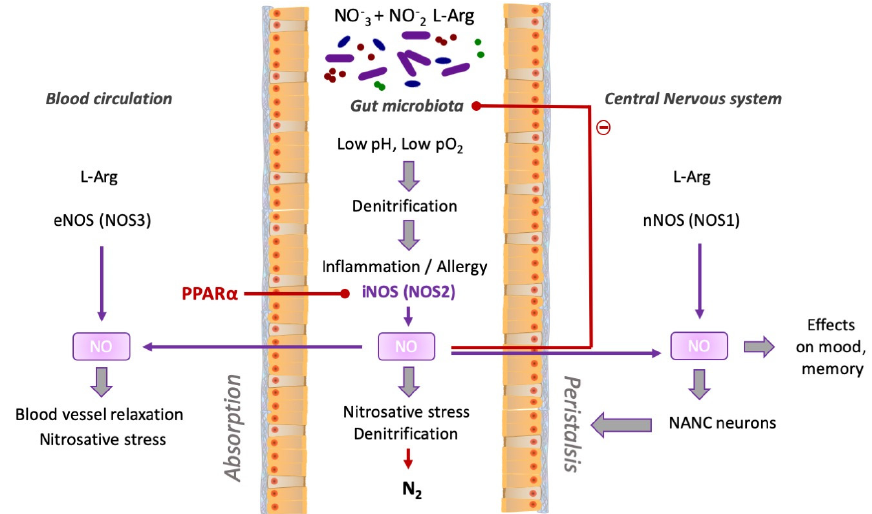
Figure 1. The main sources of nitric oxide and its metabolism in the gut.